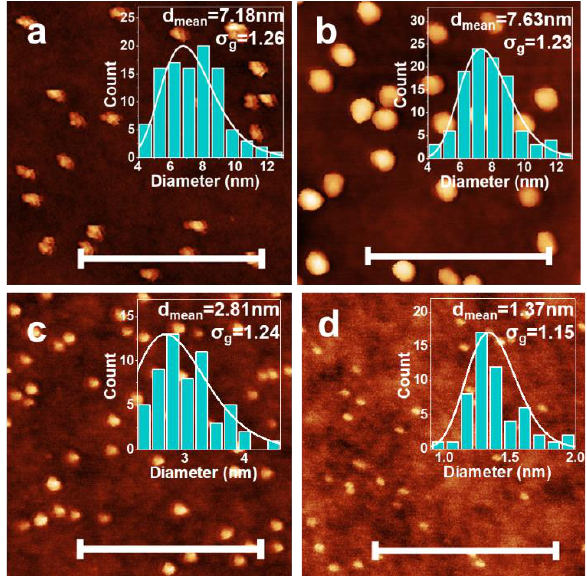
Figure 5. AFM images of Fe nanoparticles after size manipulation. ( a ) 7.18 nm Fe 2 O 3 nanoaggregates homogenously deposited on SiO 2 /Si substrates. ( b ) After reduction and reconstruction under 400 °C in H 2 , the irregular Fe 2 O 3 nanoaggregates become more rounded (oxidized again in air because of AFM characterization) without the size distribution being degraded. With other size selections, the Fe nanoparticles are precisely manipulated to obtain ( c ) 2.81 and ( d ) 1.37 nm Fe-oNPs, all possessing narrow size distributions, and a geometric standard deviation σ g of ~ 1.2. Moreover, the smaller the d mean , the smaller the absolute full width at half maximum (FWHM) for the distribution. Scale bars are all 200 nm.